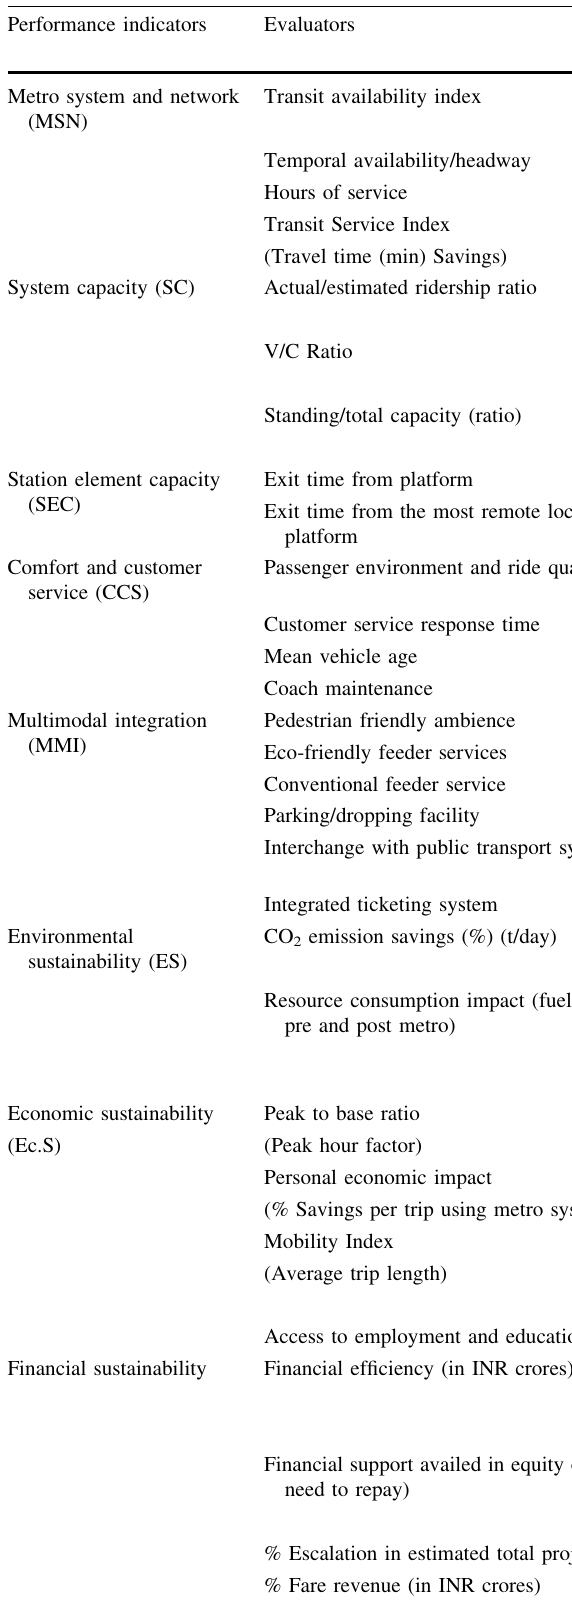
Table 1 Requisite database for integrated and sustainable benchmarking of the Metro Rail